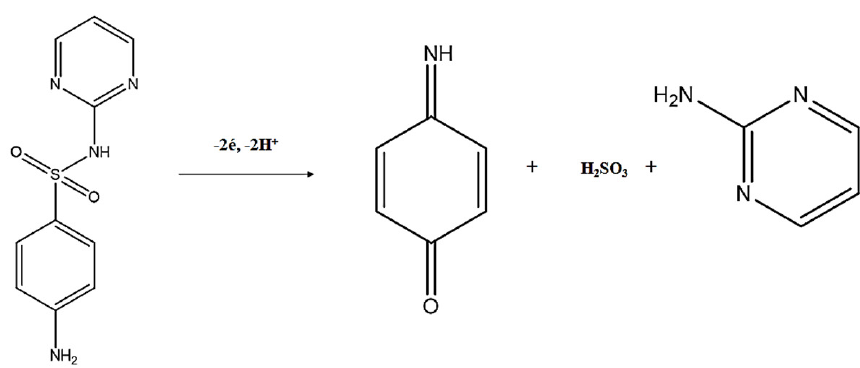
Scheme 2. Electrochemical oxidation of SDZ on the GCE.